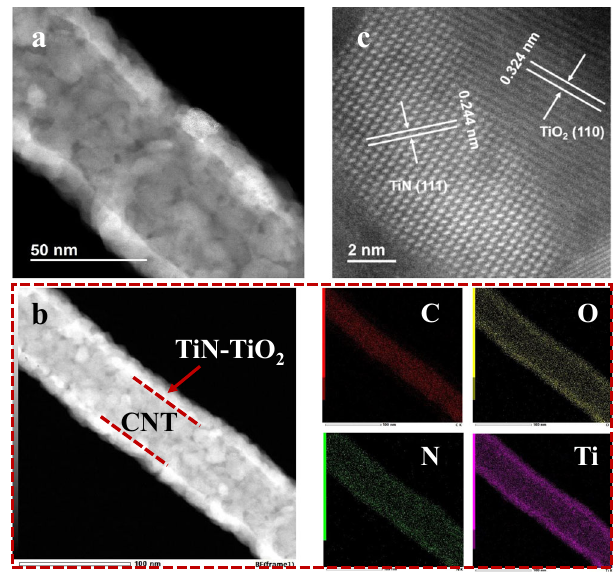
Fig. 2 Morphology characterization of CNTs@TiN – TiO 2 -5. a TEM image of CNTs@TiN – TiO 2 -5 showing the integrated TiN – TiO 2 heterostructure coated on the CNT surface. b TEM and corresponding elemental mappings of C, O, N, and Ti in CNTs@TiN – TiO 2 -5 showing the mixed and uniform distribution of TiN – TiO 2 heterostructure. c High-resolution TEM of CNTs@TiN – TiO 2 -5 showing the well-matched interface of the TiN – TiO 2 heterostructure. Source data are provided as a Source Data fi